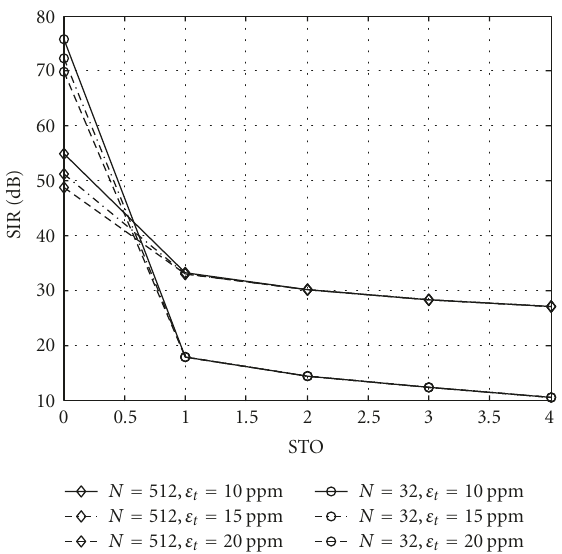
Figure 4: SIR plotted against STO under the influence of the SCFO. NDF = CFO = 0. Subcarrier index =